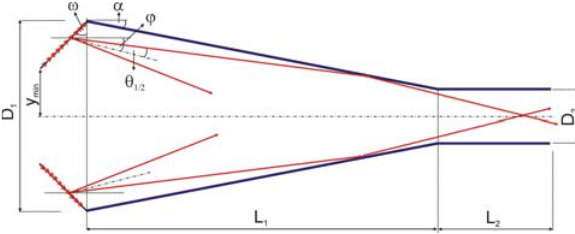
Fig. 2. Schematic layout of two-dimensional hollow-duct-system investigated